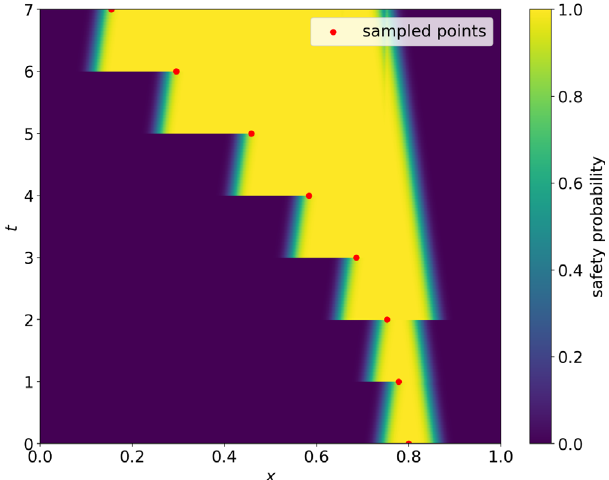
FIG. 13. Evolution of the safety probability during a safety exploration on the drifting 1D test problem. The red dot denotes the time and position of the corresponding sampled point. The safety probability is calculated with the alternative drift